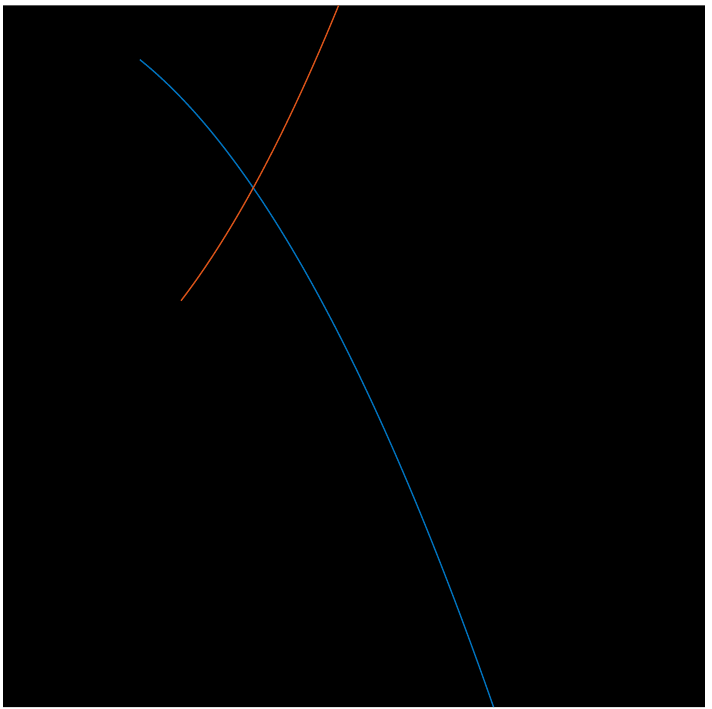
Figure 14. The trajectories of two targets. The bule line is the trajectory of the first target. The red line is the trajectory of the second target.